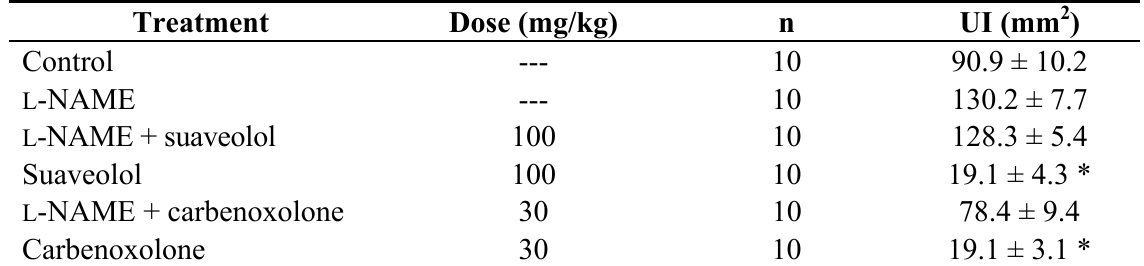
Table 3. Effect of suaveolol and carbenoxolone on gastric lesions induced by ethanol in rats pretreated with L -NAME (70 mg/kg).